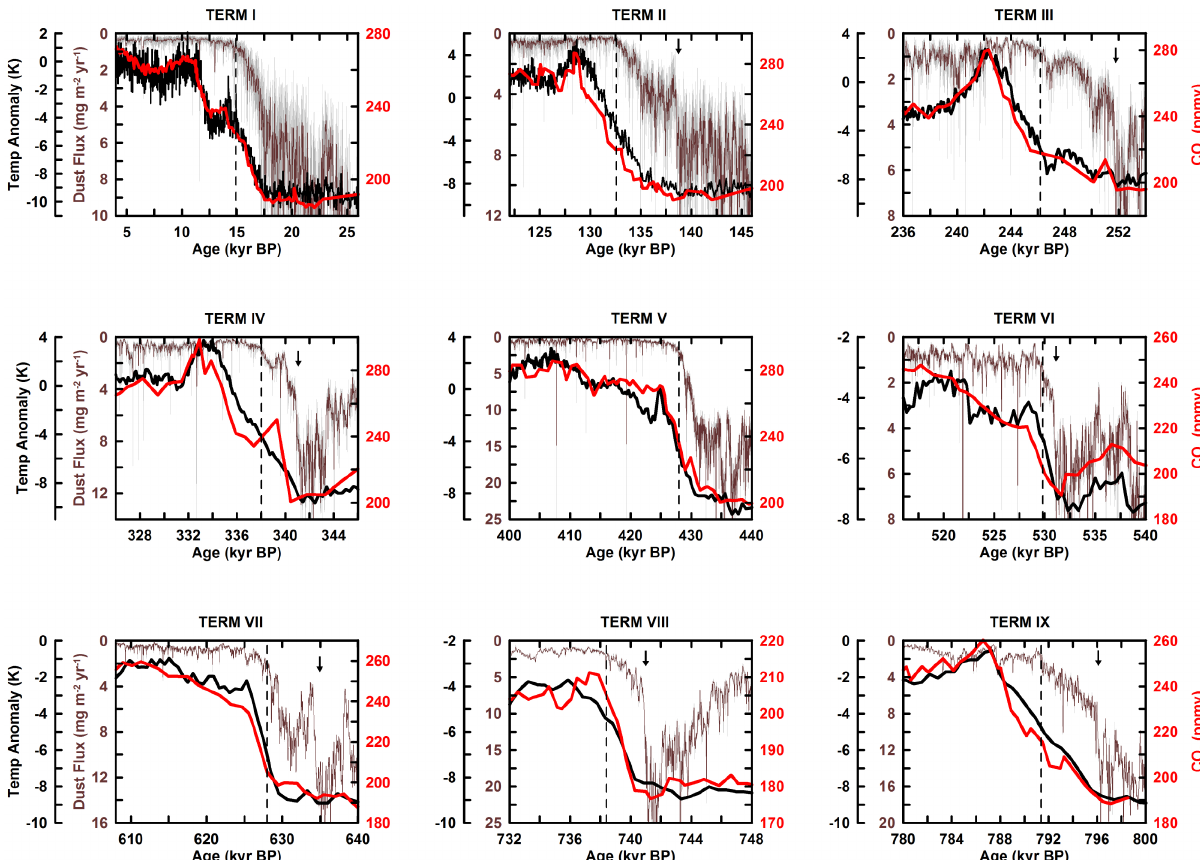
Fig. 5. Evolution of dust flux (on an inverted axis at 1cm resolution in grey overlaid with a 25yr mean in brown), EDC temperature (Jouzel et al., 2007 in black) and CO 2 concentrations (L¨uthi et al., 2008 in red) during the past nine glacial terminations. The dashed line marks the time when dust flux reaches interglacial conditions. Vertical arrows mark the rapid dust